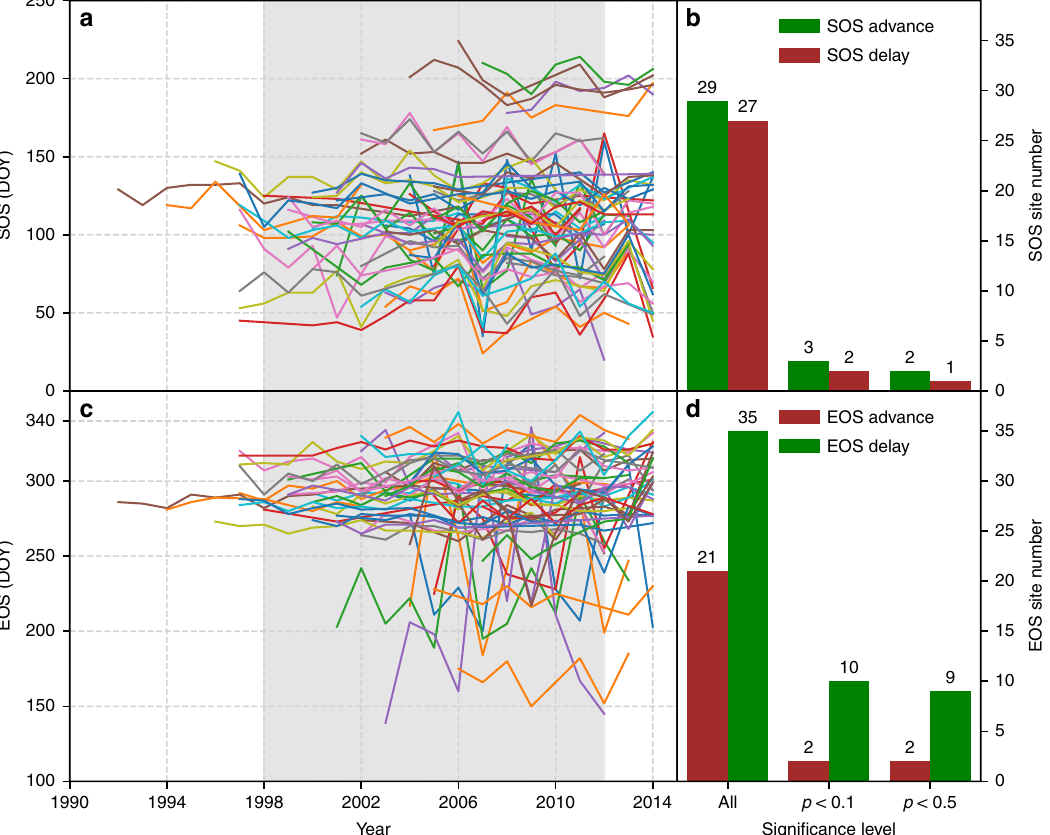
Fig. 2 Phenology trends at 56 FLUXNET sites with at least 7 years of high-quality data. The left plots are the spaghetti plots of SOS ( a ) and EOS ( c ). The right plots illustrate the number of sites with different SOS ( b ) and EOS ( d ) trends at different signi fi cance. Green bars indicate the number of sites with advanced SOS ( b ) or delayed EOS ( d ), while the brown bars indicate the number of sites with delayed SOS ( b ) or advanced EOS ( d ). All stands for the total number of sites with positive slope (or negative slope) regardless of statistical signi fi cance. p < 0.1 stands for the number of sites with positive slope (or negative slope) that was signi fi cant at p < 0.1. p < 0.05 stands for the number of sites with positive slope (or negative slope) that was signi fi cant at p < 0.05. The light gray background in a and c indicate the warming hiatus